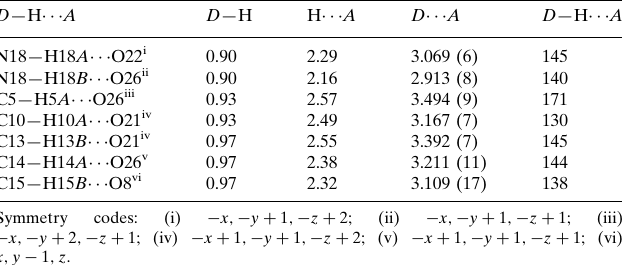
Hydrogen-bond geometry (A˚ , (cid:3)